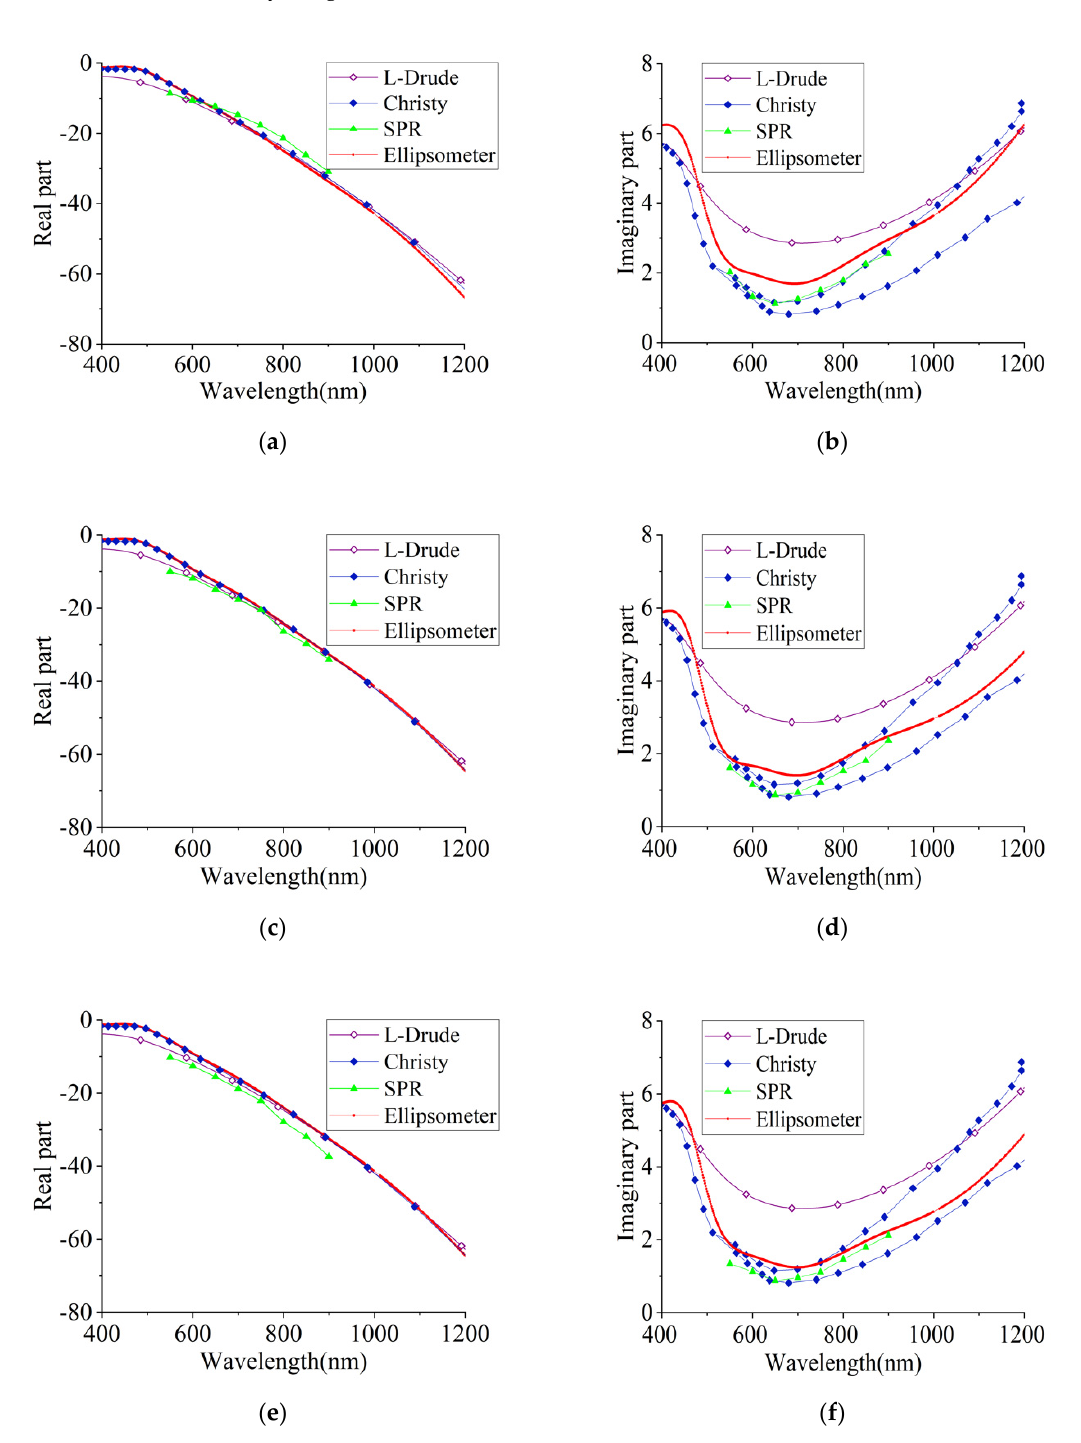
Figure 6. Dielectric constant theoretical fitting and experimental measurement results of the 35 nm ( a,b ), 45 nm ( c,d ), and 55 nm ( e,f ) gold films.